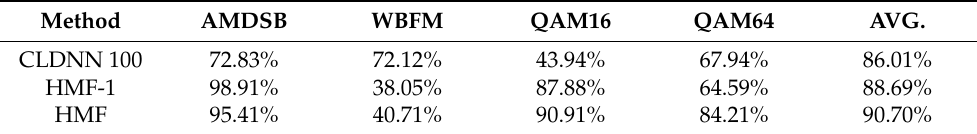
Figure 10. Confusion matrices of ( a ) CLDNN 100, ( b ) HMF-I, and ( c ) HMF on RadioML2016.10a (SNR = 12 dB). Table 2. Classification accuracy comparison of different methods (SNR = 12 dB).